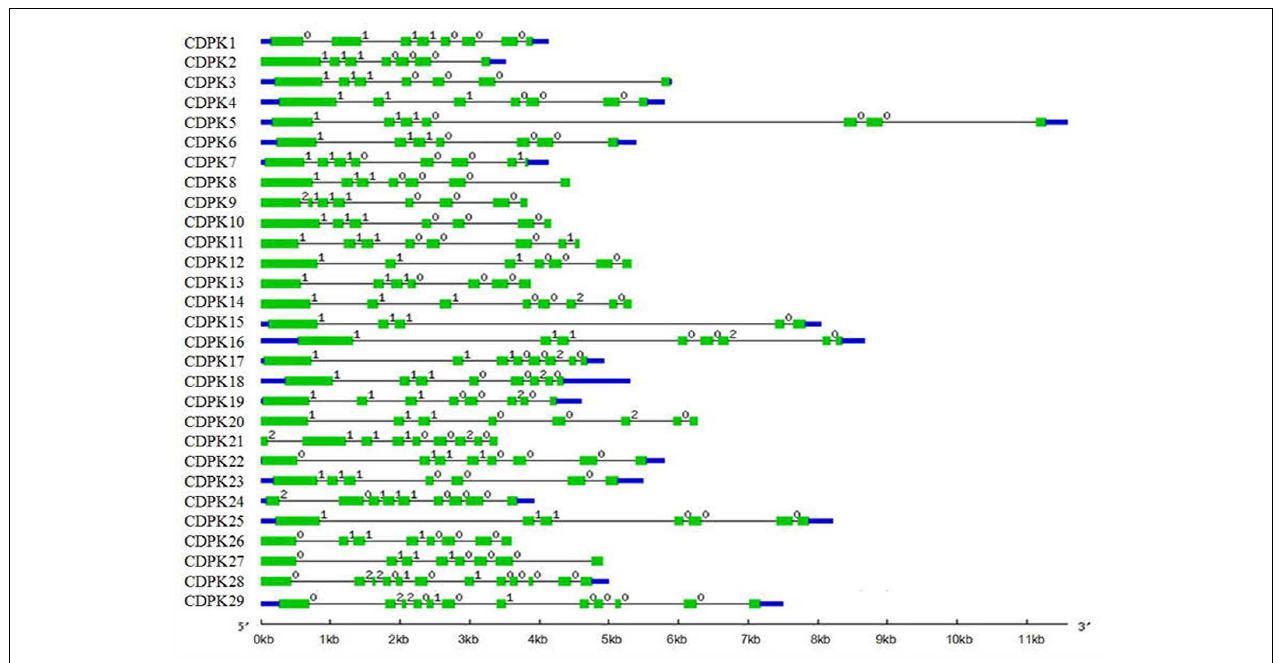
FIGURE 3 | Gene structure in tomato CDPK gene family. Blue bars stand for untranslated regions (UTR). One green bars stand for an exon and one black string stand for an intron. The number (0, 1, and 2) above the black strings stand for intron phase.